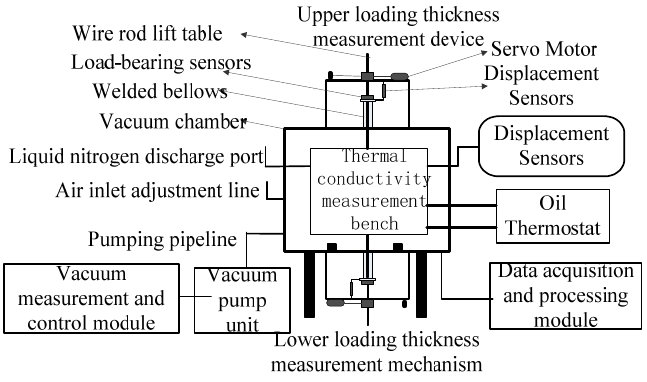
Figure 1. Schematic diagram of vacuum cryogenic thermal conductivity testing system.